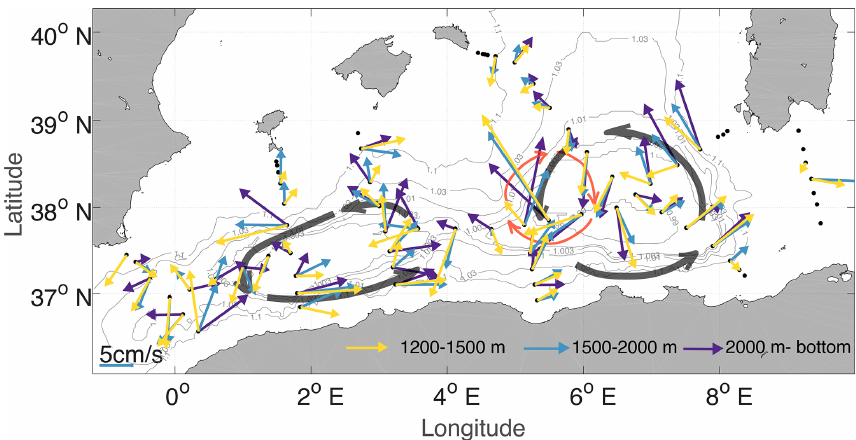
Figure 4. Map of all the CTD casts carried out during the SOMBA-GE2014 cruise in 2014. LADCP measurements are indicated with arrows. They have been averaged within three layers: 1200–1500m (yellow), 1500–2000m (blue) and 2200m (bottom; purple). The black dots are the cast locations. The gray contours represent f/H contours, normalized by f 0 /H 0 ( f 0 being calculated at a latitude of 37 ◦ 45 (cid:48) N, and H 0 = 2797m). The transparent black arrows represent the approximate position and the direction of the Algerian Gyres. The red arrows indicate the position of a strong barotropic anticyclonic Algerian Eddy during the